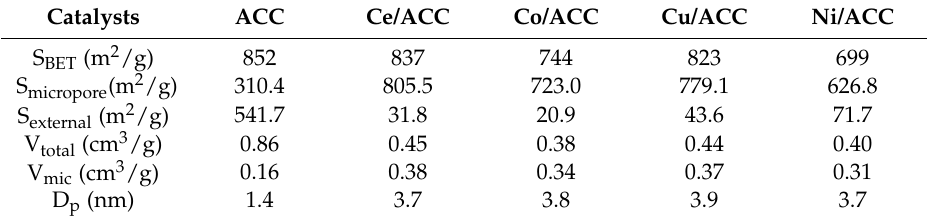
Table 1. Surface areas and pore characteristics for activated carbon